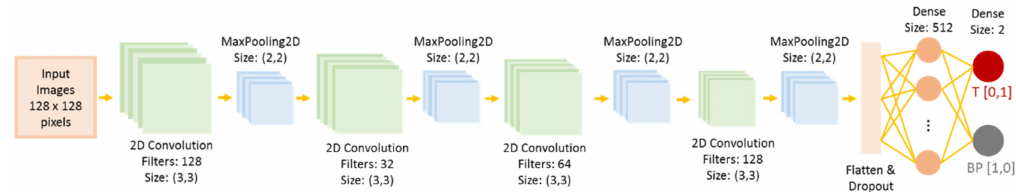
Table S1. Clinical patient data with patient ID, age in years (yrs), gender (f–female, m–male), location and diagnosis according to the 2016 WHO Classification of Tumors of the Central Nervous System, Table S2. Image parameters according to histological glioma subtype, Table S3. Image parameters according to IDH mutation